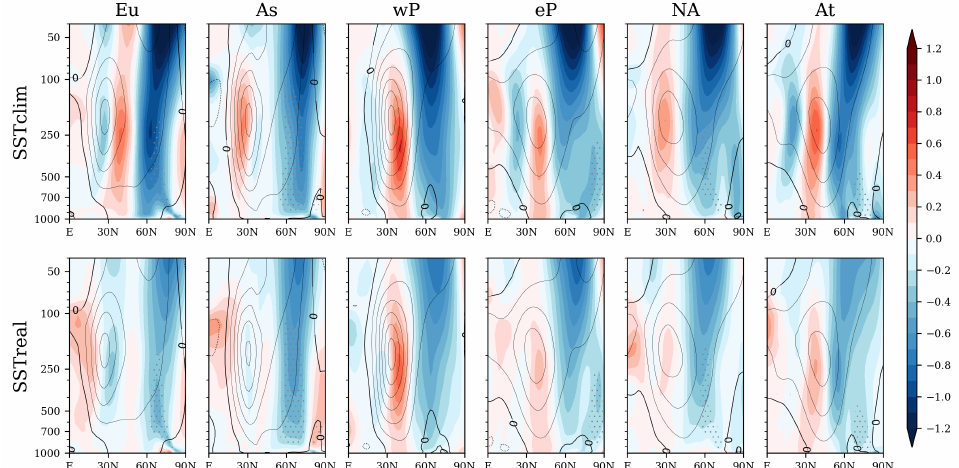
Figure 4. Regional winter responses of the zonal mean zonal wind ( u, m/s , where the overbar indicates a zonal average), plotted as a function of latitude and height (hPa) for the SSTclim ( top ) and SSTreal ( bottom ) cases. The black contours show the corresponding climatologies of the control ensembles (contour interval every 10 m/s with dashed lines for negative values). Dotted areas indicate regions where the differences between the experimental and control ensembles are statistically significant at the 95% confidence